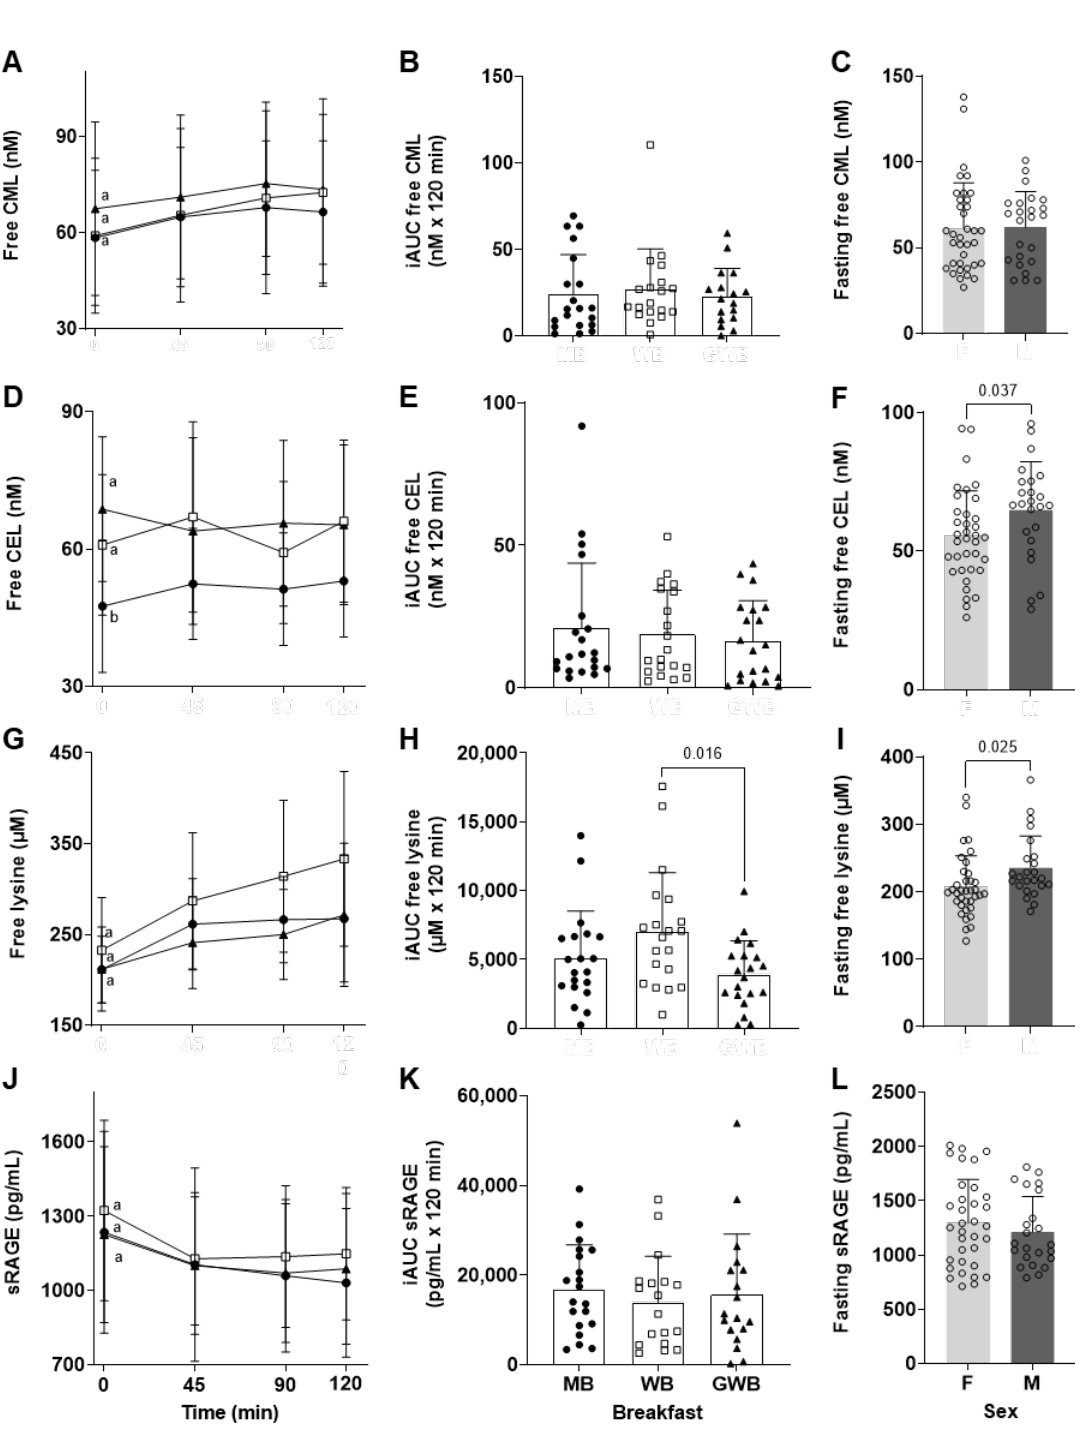
Figure 2. Circulating levels of free AGEs, free lysine, and sRAGE in human plasma. Kinetics of ( A ) free CML, ( D ) free CEL, ( G ) free lysine; and ( J ) sRAGE were compiled from four plasma samples 0 min (fasting), 45, 90, and 120 min after intake of the MB (●), WB (□), and GWB ( ▲ ) breakfasts. Letters denote statistical similarity among the different fasting measures prior to breakfast consumption ( p < 0.05). The iAUC 0–120 min of each breakfast is shown for ( B ) free CML, ( E ) free CEL, ( H ) free lysine; and ( K ) sRAGE levels. Gender effects for fasting ( C ) free CML, ( F ) free CEL, ( I ) free lysine; and ( L ) sRAGE levels are shown for the pool of female ( F ) and male (M) volunteers over the 3 interventions ( n = 60). For both the iAUC 0–120 min and gender analyses, statistically significant differences are indicated with significant p values at the level α = 0.05. Data represent mean ± SD.